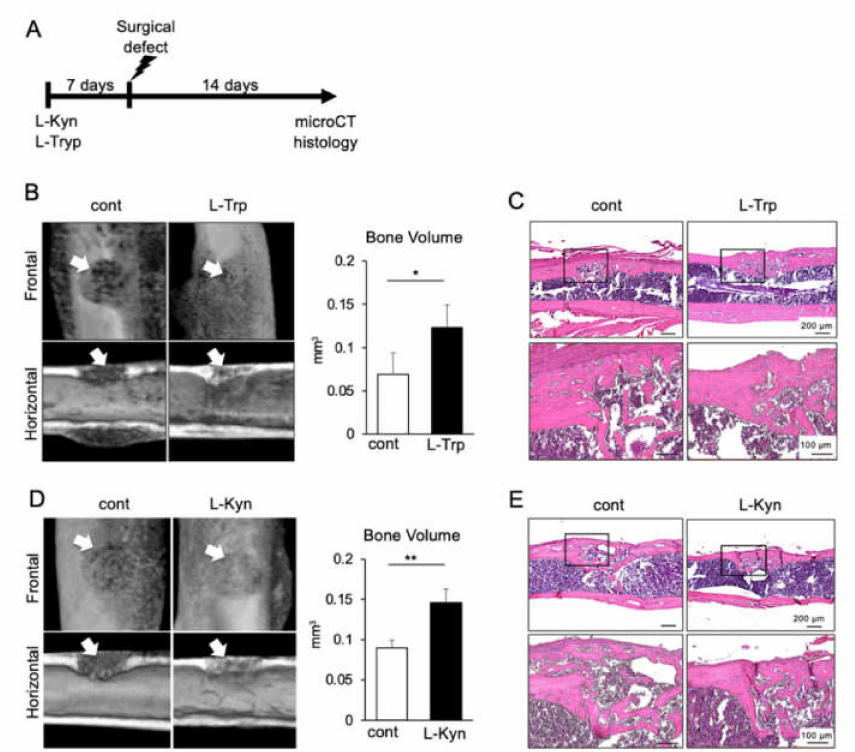
Figure 5. Effect of tryptophan or kynurenine on bone regeneration in mice femur surgical defect. ( A ) Schema showing the study design. Mice were then administered the two amino acids for 2 more weeks. ( B , D ) Three-dimensional micro-CT images of mouse femur defects after intraperitoneal injection with PBS or L-Trp (50 mg/kg) or L-Kyn (50 mg/kg). The bone healing ability after three weeks of L-Trp or L-Kyn-treated group was accelerated compared to the respective PBS-injected control group. The analysis was performed with Skyscan software. The images are representative of four different samples. The white arrow indicates the defect. ( C , E ) Histological analysis of mouse femurs in the defect area. Note the amount of regenerated bone volume in L-Trp ( C ) and L-Kyn-treated ( E ) groups. Data represent the mean ± SD (n = 4). * p < 0.05, ** p < 0.01, unpaired t